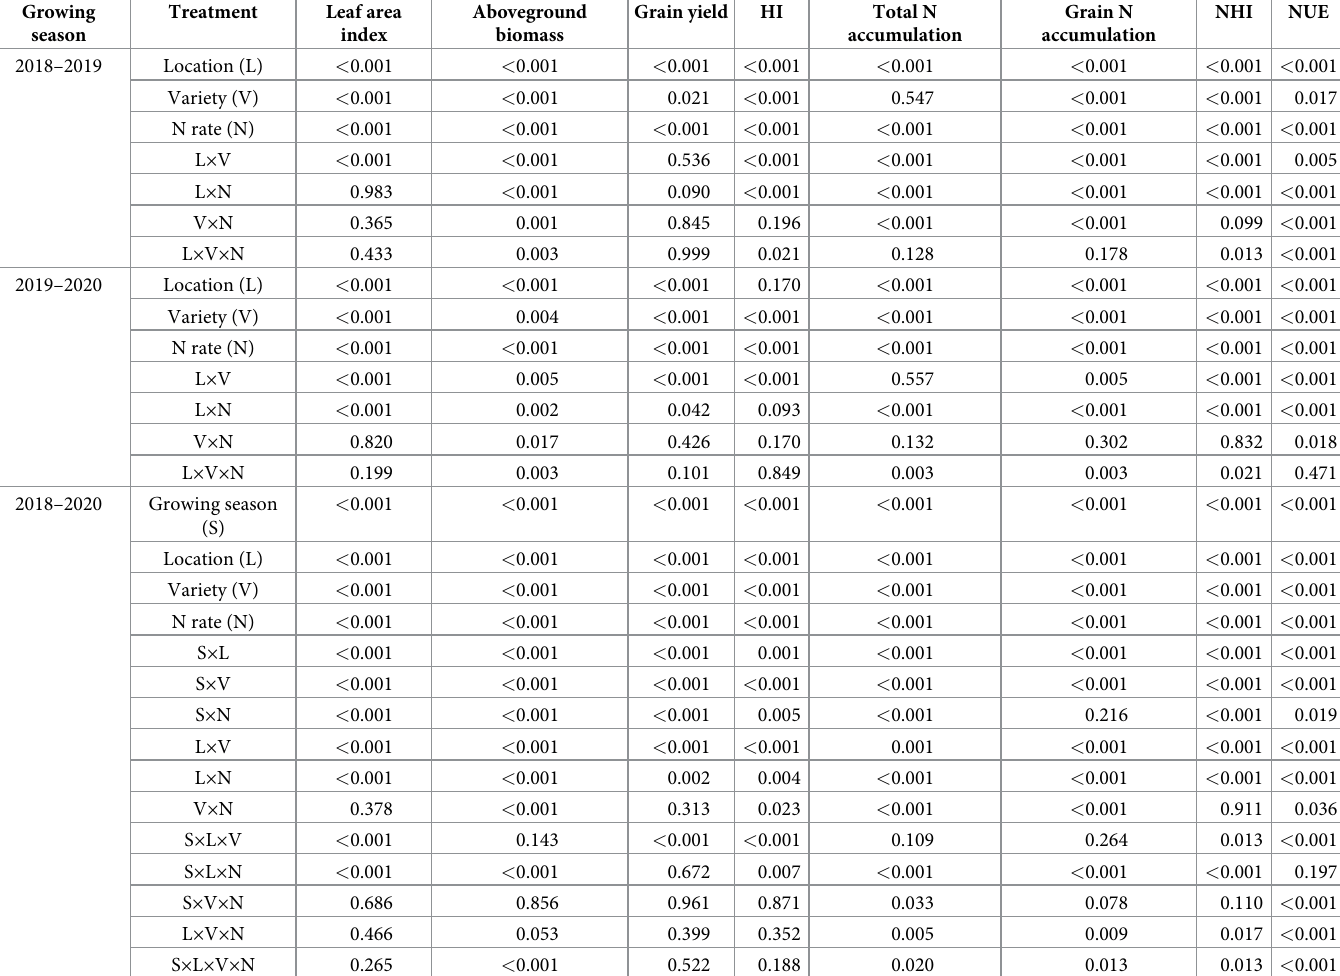
Table 2. Significance level ( P values) of the effects of location, variety and N rate on leaf area index, aboveground biomass, grain yield, HI, total N accumulation, grain N accumulation, NHI and NUE of winter